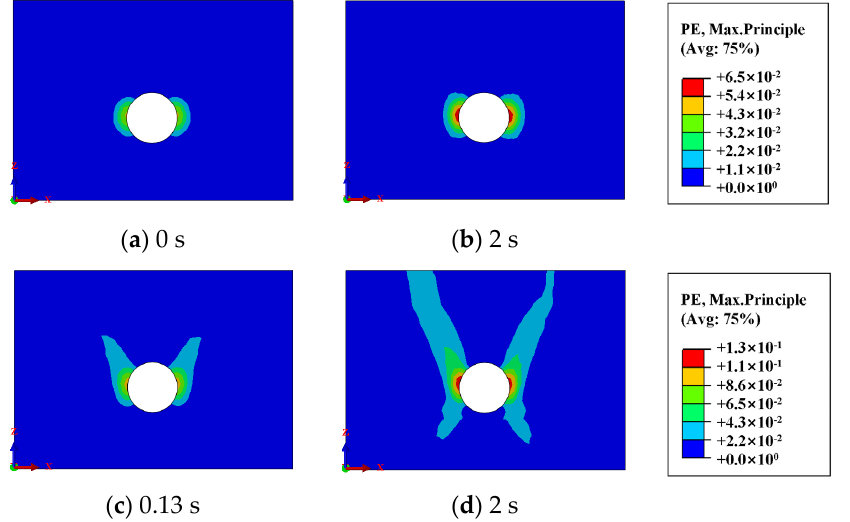
Figure 7. Evolution of plastic damage of the normal coal roadway under the impact load of ( a , b ) the Schmidt hammer at 0 s and 2 s and the impact load of ( c , d ) the weight fall at 0.13 s and 2 s, respectively.